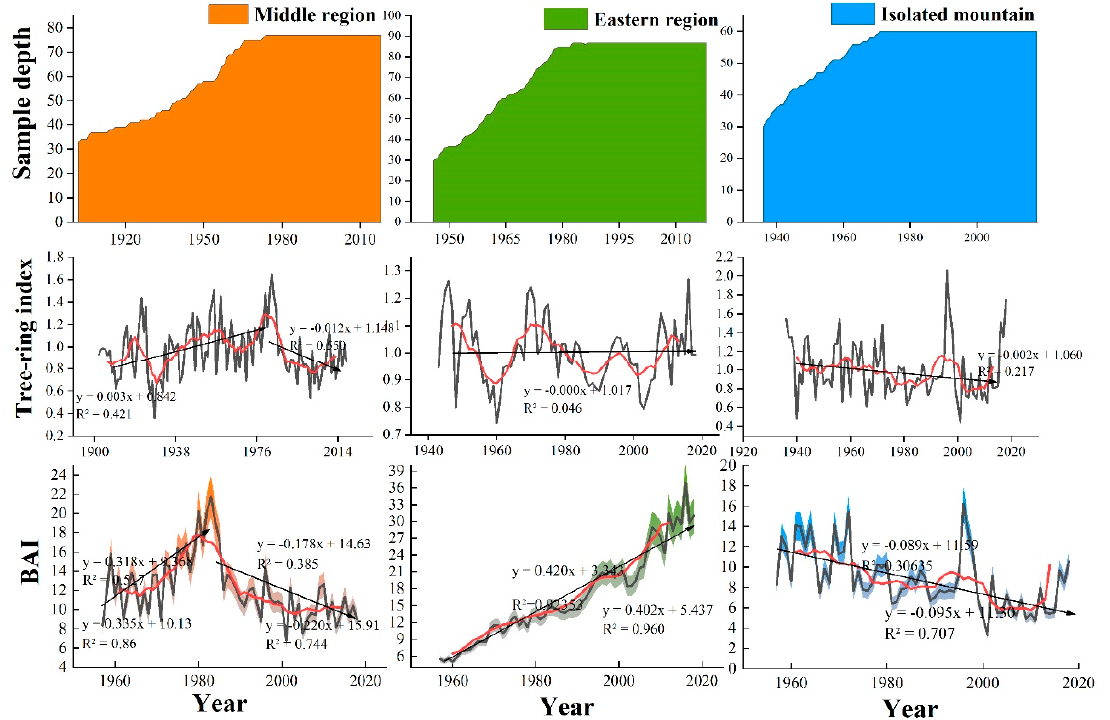
Figure 4. Interannual variabilities of tree-ring width and basal area increment (BAI) in three Central and Eastern Qilian Mountain regions.